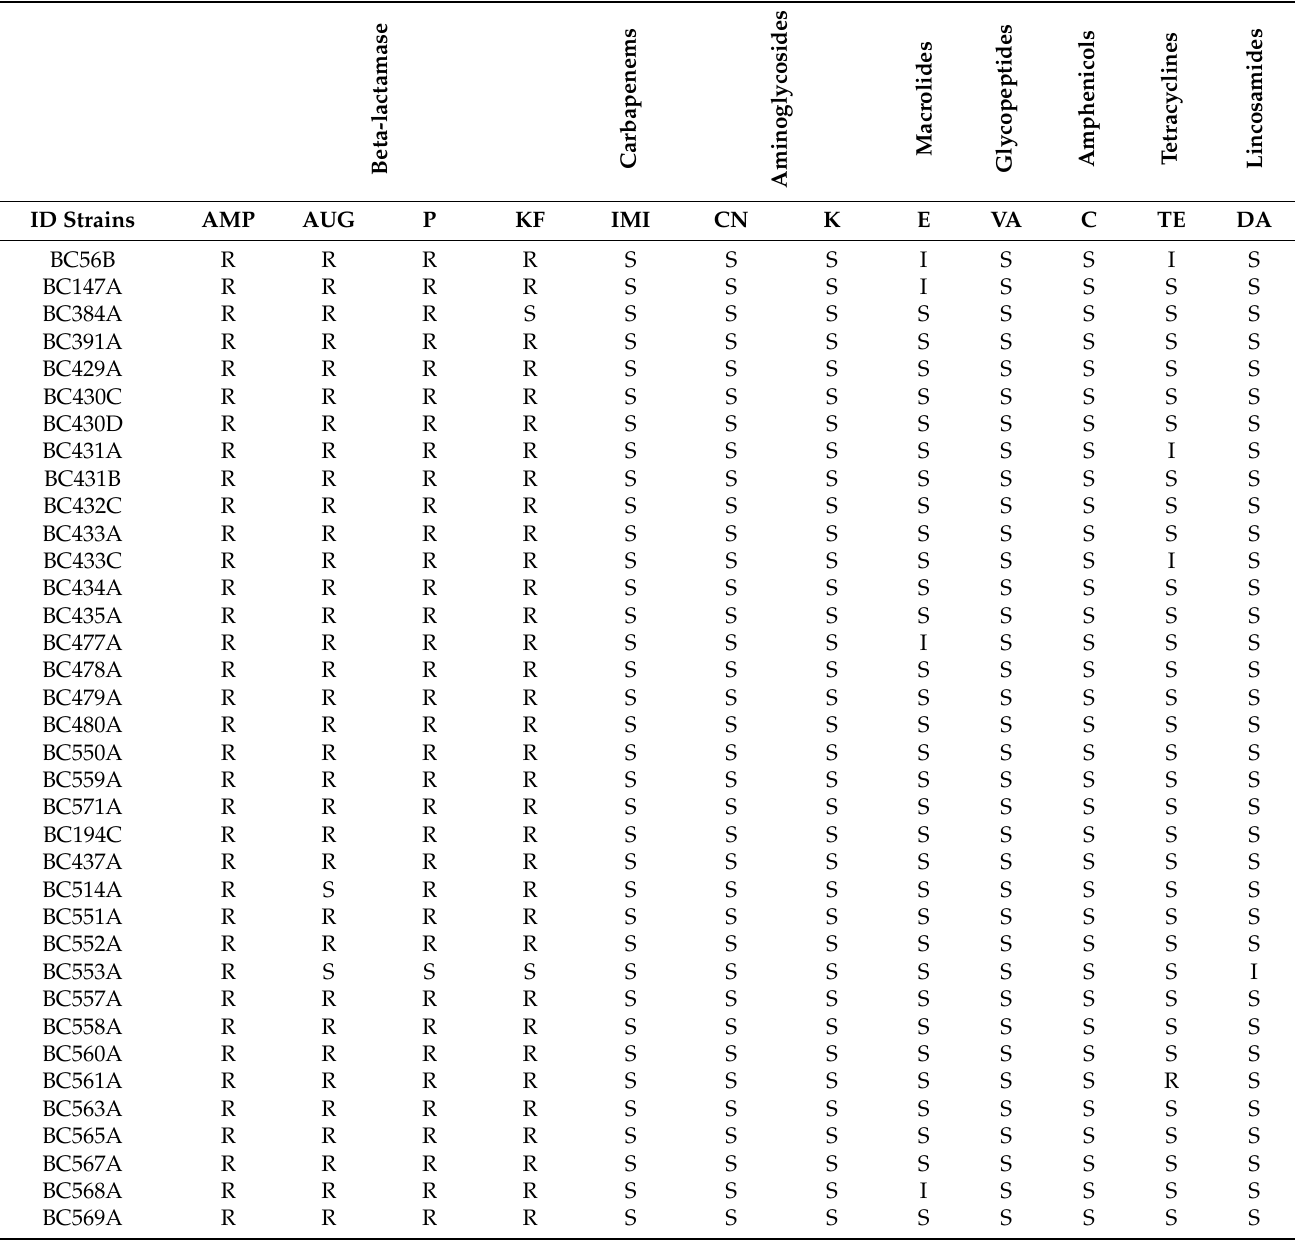
Table 3. Antimicrobial resistance pattern of the B. cereus s.l.